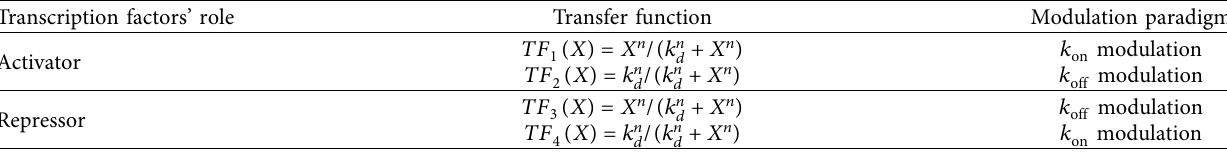
Table 1: Transfer function of gene